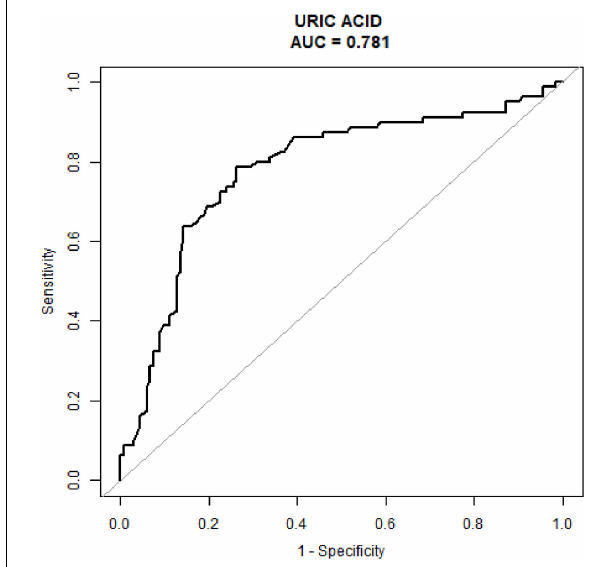
FIGURE 1 | The diagnostic value of serum uric acid levels was evaluated using receiver operating characteristic analysis testing patients with Meige’s syndrome against healthy